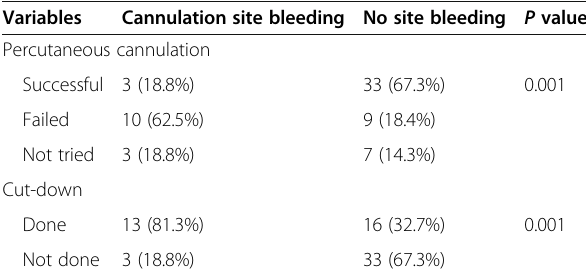
Table 5 The correlations between cannulation site bleeding and cannulation techniques